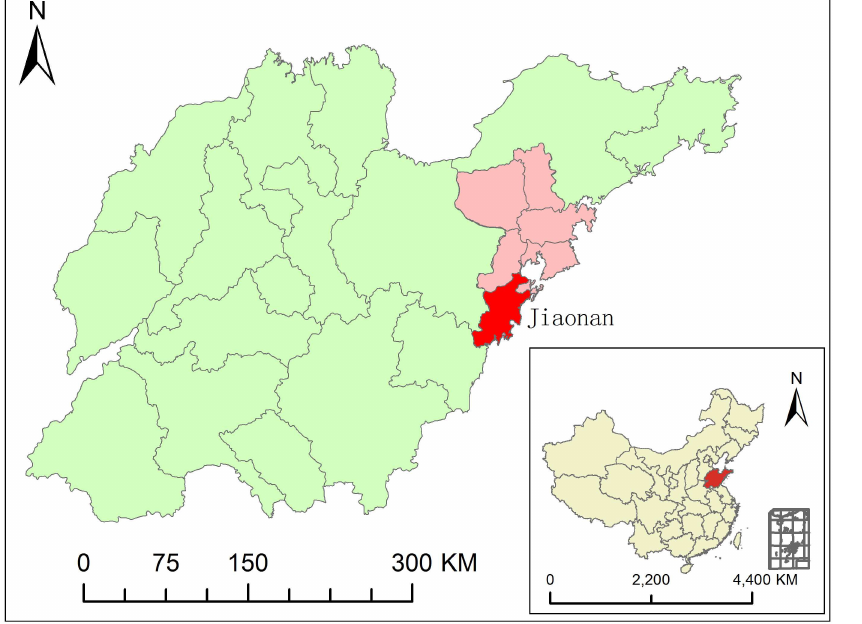
Fig 1. Geographical location of study